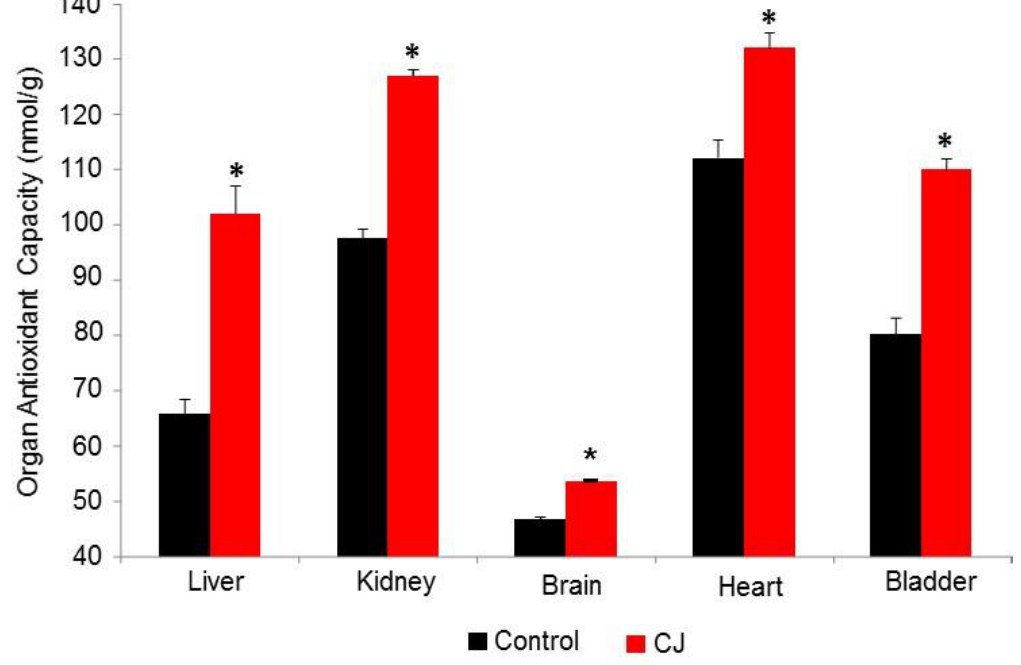
Figure 3. Hamster Organ Antioxidant Capacity after CJ administration. * p < 0. 0001 vs. the